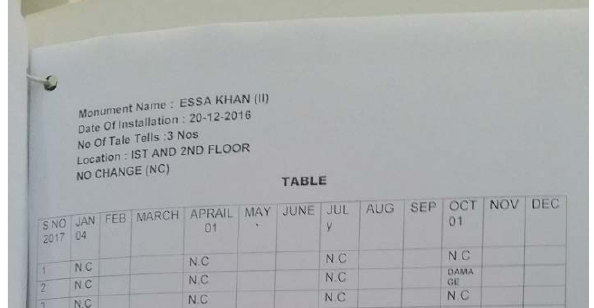
Figure 4. Logbook showing no changes after the inspection